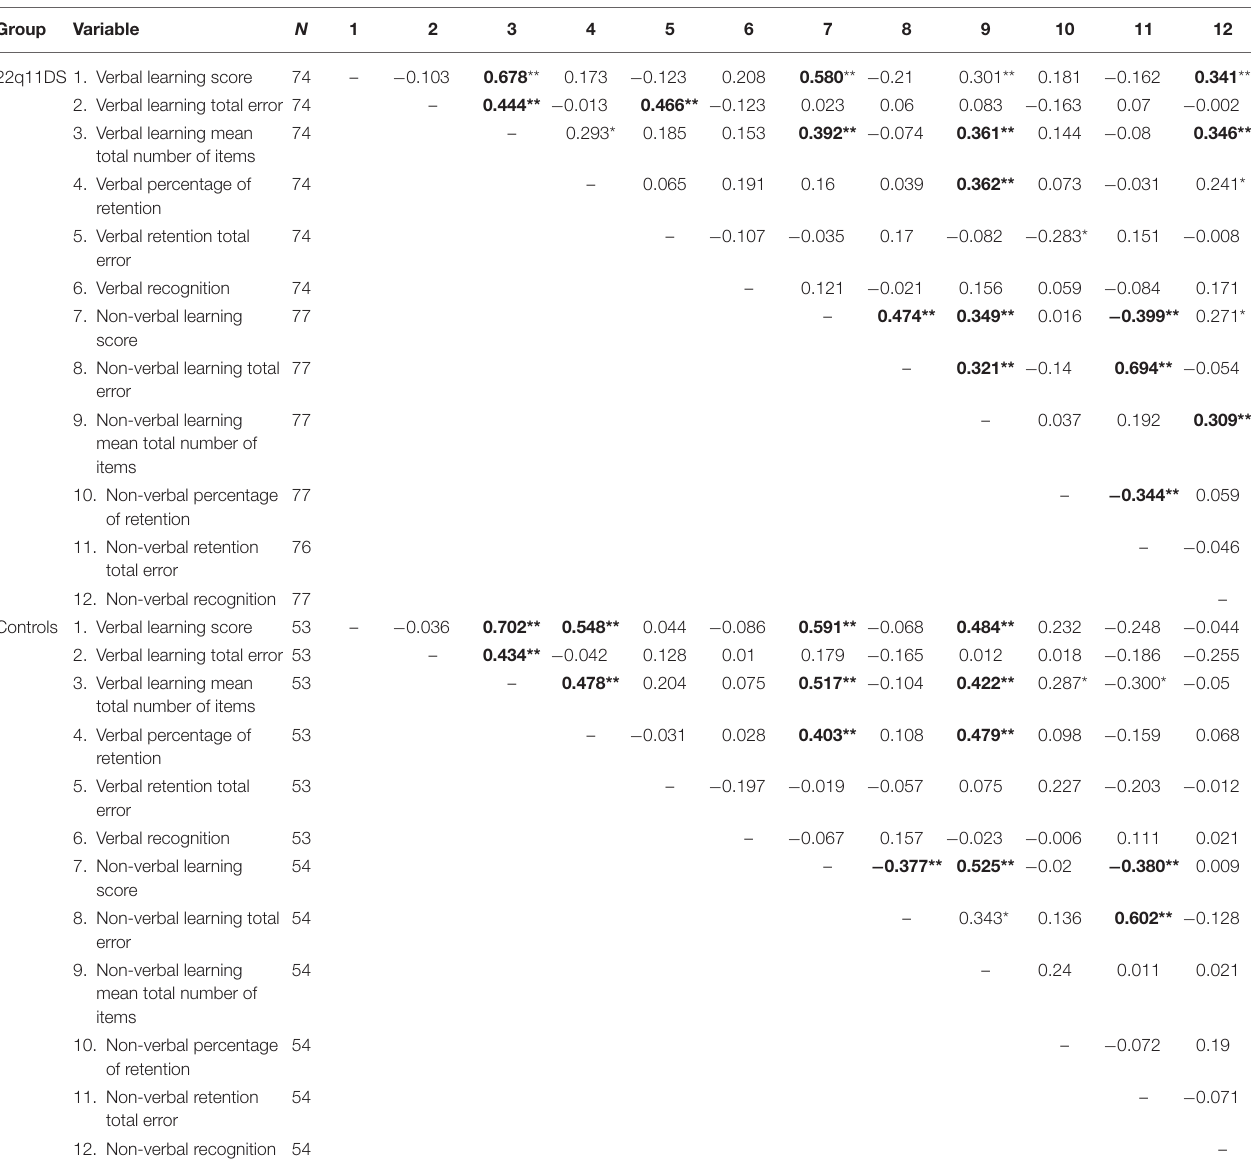
TABLE 4 | Spearman correlations for learning and memory variables. Group